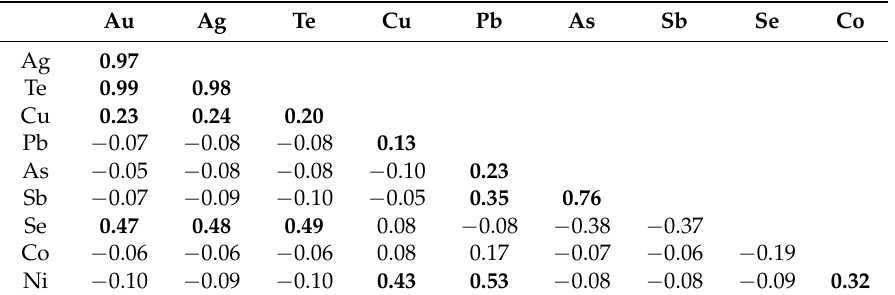
Figure 12. Correlation diagrams of different elements vs. Au concentration in the LA-ICP-MS spots: ( a ) Ag; ( b ) Te; ( c ) Cu; ( d ) As; ( f ) Ni. ( e ) plot of Ag vs. Te; ( g ) plot of Se vs. Te; ( h ) plot of Pb vs. Ni; ( i ) plot of Sb vs. As. R: correlation coefficients. The gold saturation line is from Reich et al. (2005) [43]. Table 2. Correlation coefficients between Au and other elements of